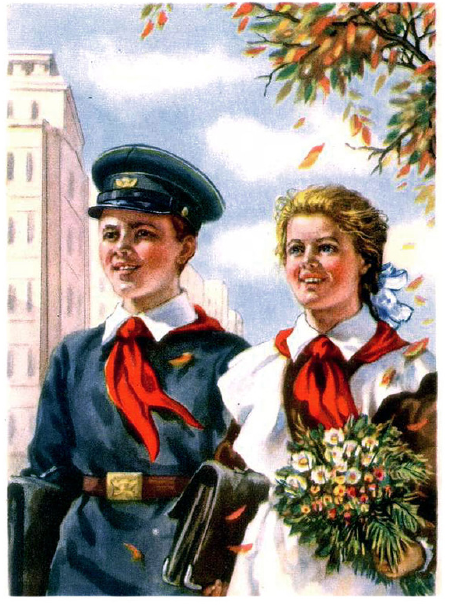
Picture 5. Stalinist school uniform for Pioneers in the late 1940s – the early 1950s, a communist organization for children (http://dubikvit.livejournal.com/57103.html)